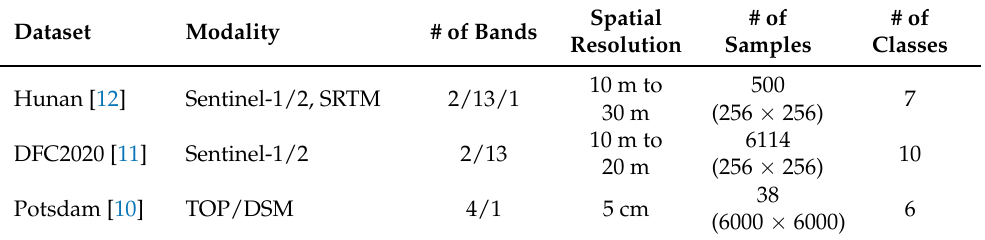
Table 1. Dataset